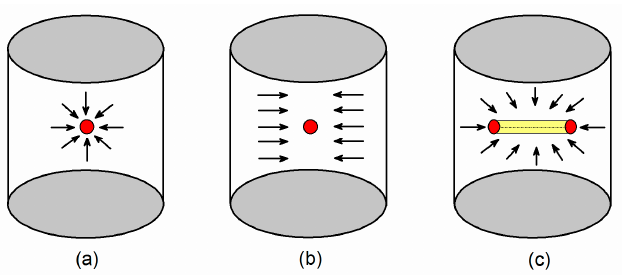
Figure 7. Schematic of flow regimes for a horizontal well incorporating geomechanics in a naturally fractured reservoir ( ε D = 0.05). ( a ) Radial flow; ( b ) Linear flow; ( c ) Pseudo-radial flow.